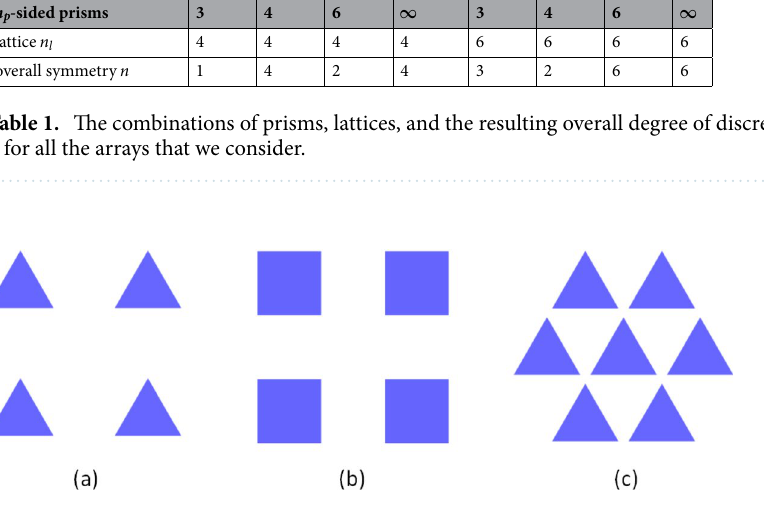
Figure 3. ( a ) An array of triangular prisms ( n p onto itself if it is rotated by any angle rather than multiples of 360 ◦ (overall symmetry n 4 ) arranged in a square lattice ( n of square prisms ( n p = 4 ), and ( c ) an array of triangular prisms ( n (overall symmetry n = is symmetric under rotations by multiples of 120 ◦ (overall symmetry n